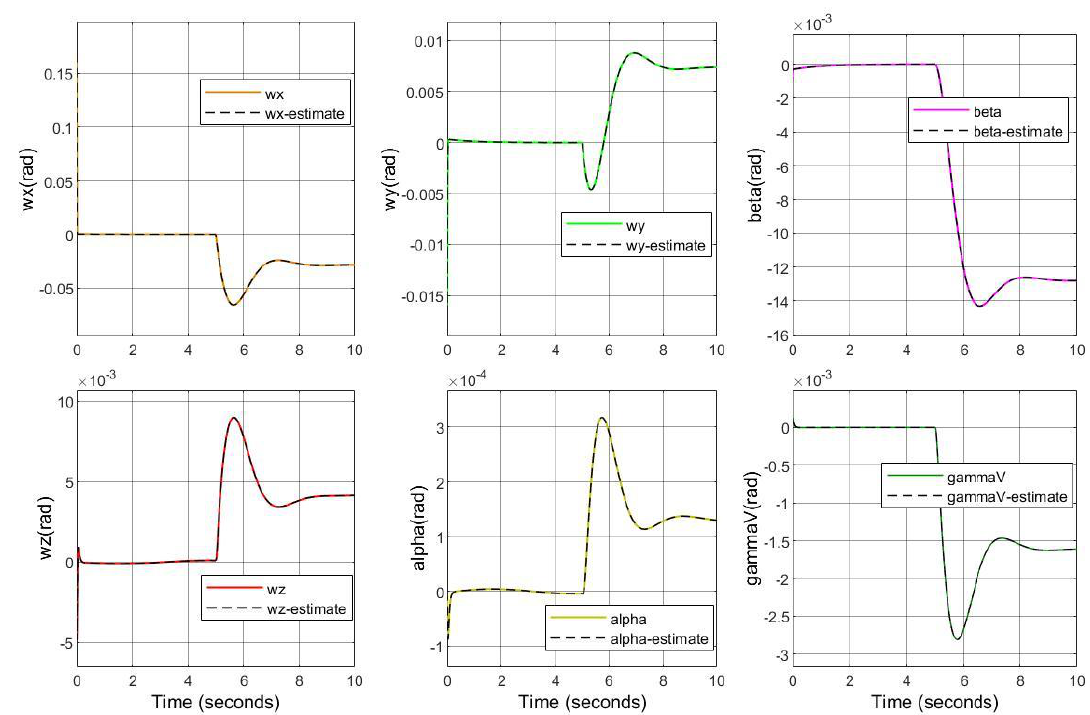
Figure 7. Detection simulation results of actuator stuck fault from input 4.